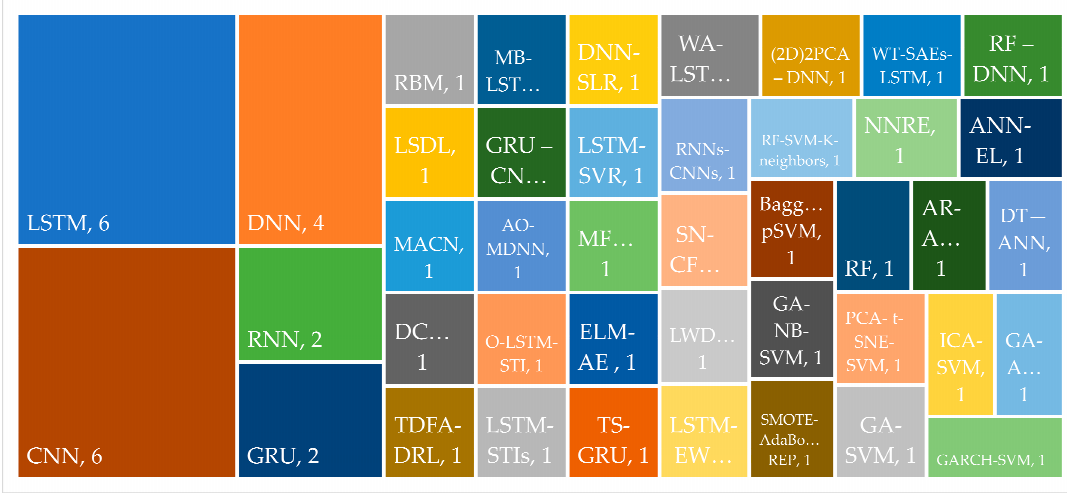
Figure 3. Notable methods of deep learning and hybrid deep learning models applied in economics-related fields; the size of the rectangle is proportional to the number of publications (source: WoS).